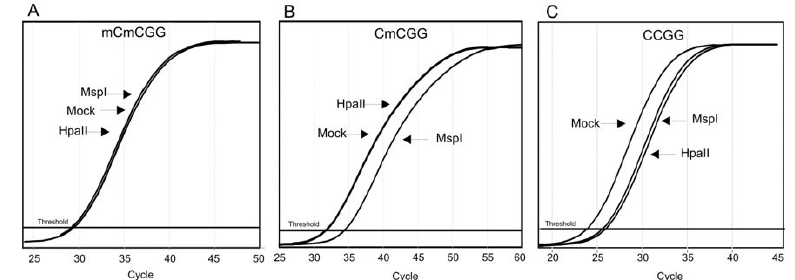
Figure 2. Real-time amplification curves of digestion products. The profiles indicate the methylation status of the two cytosine residues present at the restriction site: ( A ) both cytosines methylated; ( B ) only internal cytosine methylated; ( C ) both cytosines unmethylated.